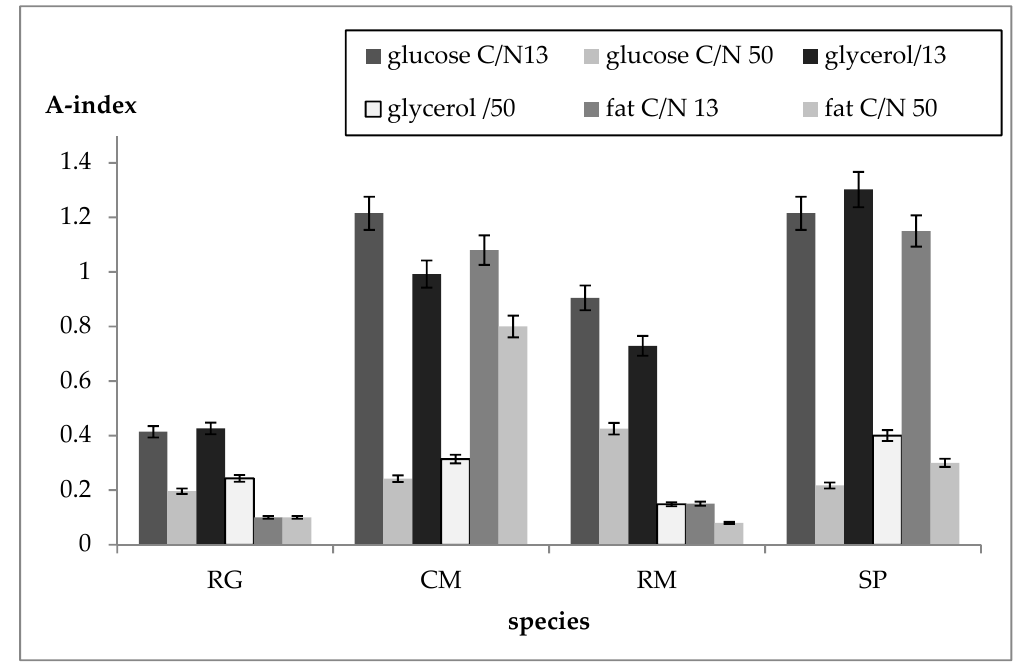
Figure 5. Production of biosurfactants by individual strains at different C/N ratios. Abbreviations: RG ( Rhodotorula glutinis CCY 20-2-26), CM ( Cystofilobasidium macerans CCY 10-1-2), RM ( Rhodotorula mucilaginosa CCY 19-4-6) and SP ( Sporobolomyces pararoseus CCY 19-9-6); A-index was evaluated as absorbance at 345 nm when compared with blank.